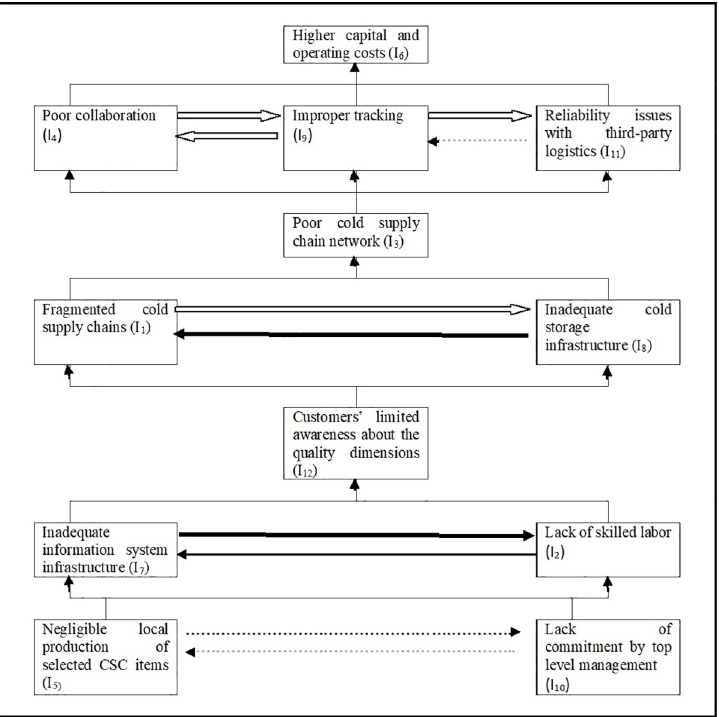
Fig 2. The FISM based model illustrating the structural relations with their respective dominance of interaction.